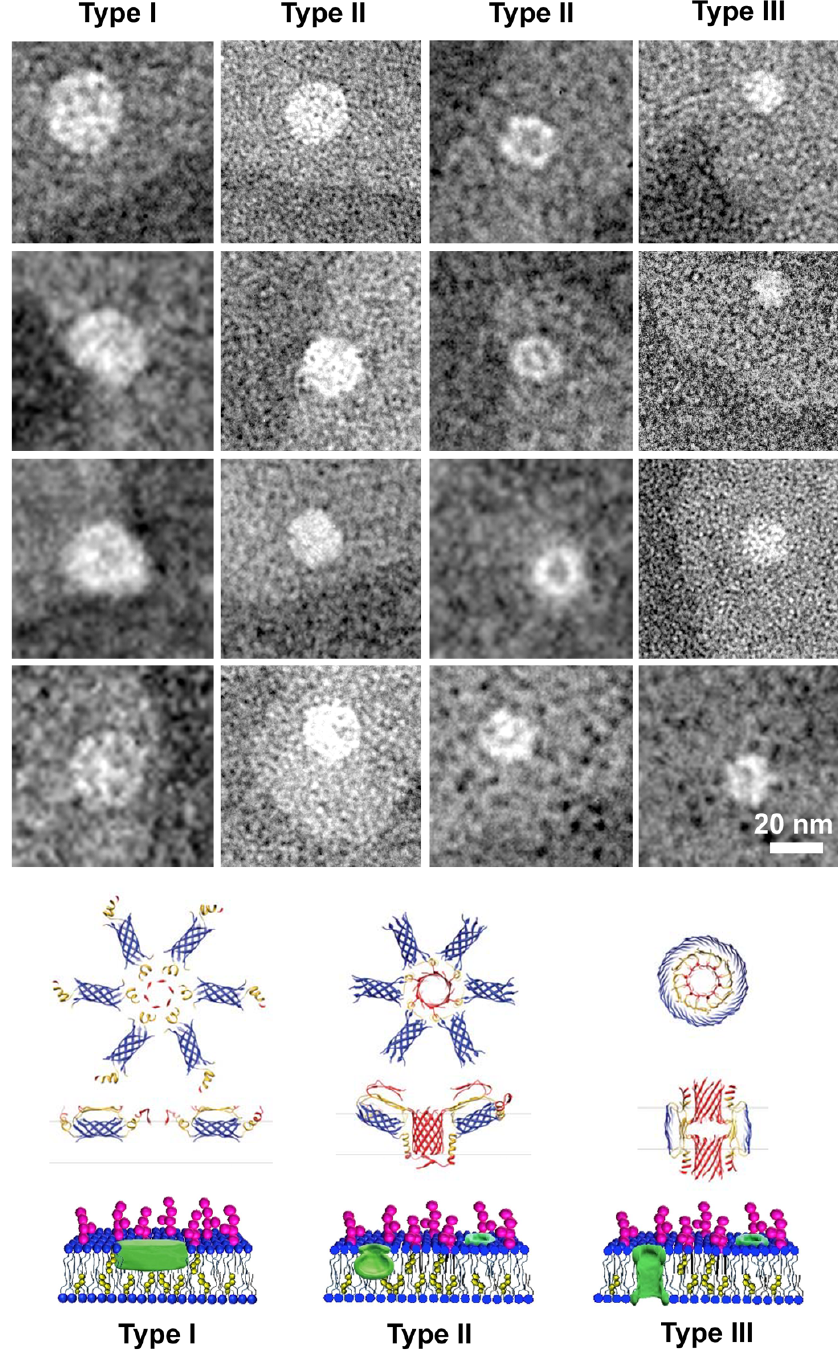
Figure 9. Membrane-bound sCT assemblies visualized by EF-TEM (top) organized in tree decreasing size types, compared with the model proposed by Shafrir et al. for A β [44] (middle). Type I represents the formation of hexameric patches at the surface, Type II their tilting due to the incorporation in the membrane (in the right column the central pore can be observed) and Type III the well-formed membrane pore. A possible interpretation based on the neutron reflectometry study of Rondelli et al. [66], is also reported (bottom).